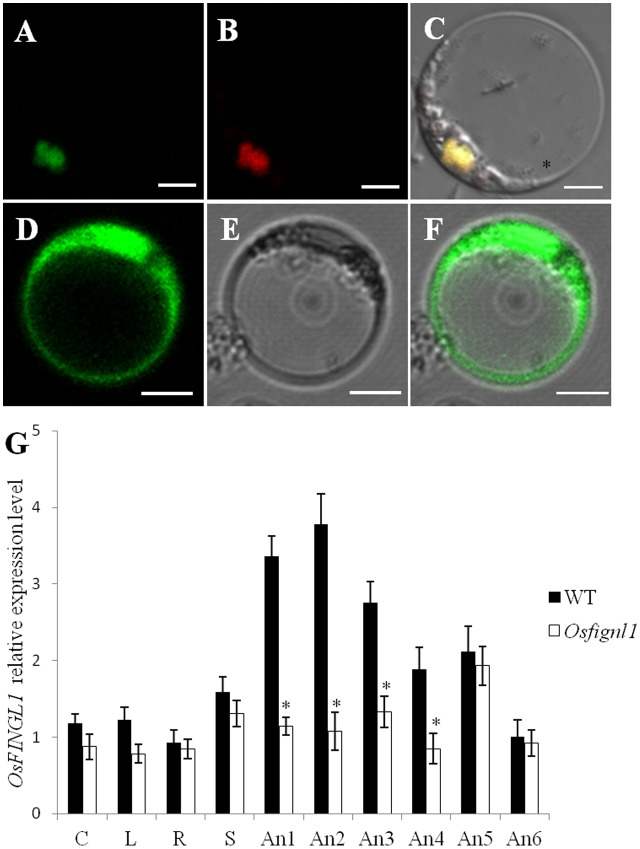
Subcellular localization and expression pattern analysis of rice OsFIGNL1. (A) Subcellular localization of full-length OsFIGNL1 fused with GFP is detected in nucleus. (B) OsMADS3-mCherry was used as a nuclear marker. (C) A merged image of (A,B). (D–F) GFP alone is detected throughout the rice protoplast cells. Bars = 5 μm. (G) Expression pattern analysis of rice OsFIGNL1. R, mature root; C, mature culm; L, mature leaves; S, mature sheath. An1, spikelet lengths from 4 to 5 mm; An2, spikelet lengths from 5 to 6 mm; An-3, spikelet lengths from 6 to 7 mm; An-4, spikelet lengths from 7 to 8 mm; An-5, spikelet lengths from 8 to 9 mm; An-6, spikelet lengths > 10 mm. OsActin1 was used a control for normalizing expression in all assays. ∗Indicate significant difference at P < 0.01.